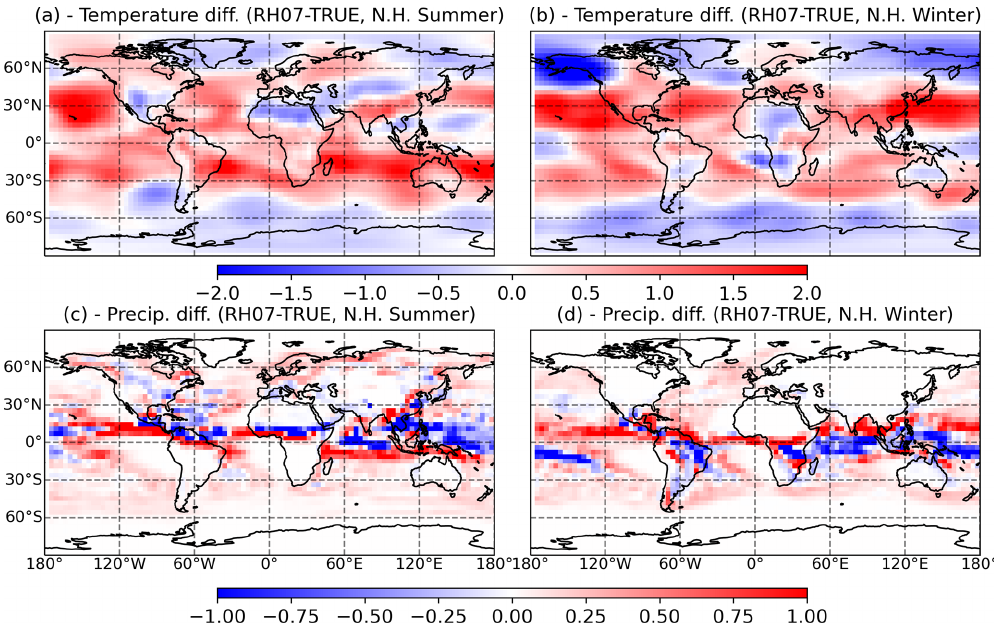
Figure 11. The 30-year mean difference between the TRUE model simulation and the RH07 for the Northern Hemisphere summer (June, July, and August, a , c ) and the Northern Hemisphere winter (December, January, and February, b , d ) for temperature at σ = 0 . 5 ( a , c , K ) and for convective precipitation ( c , d , mmd − 1